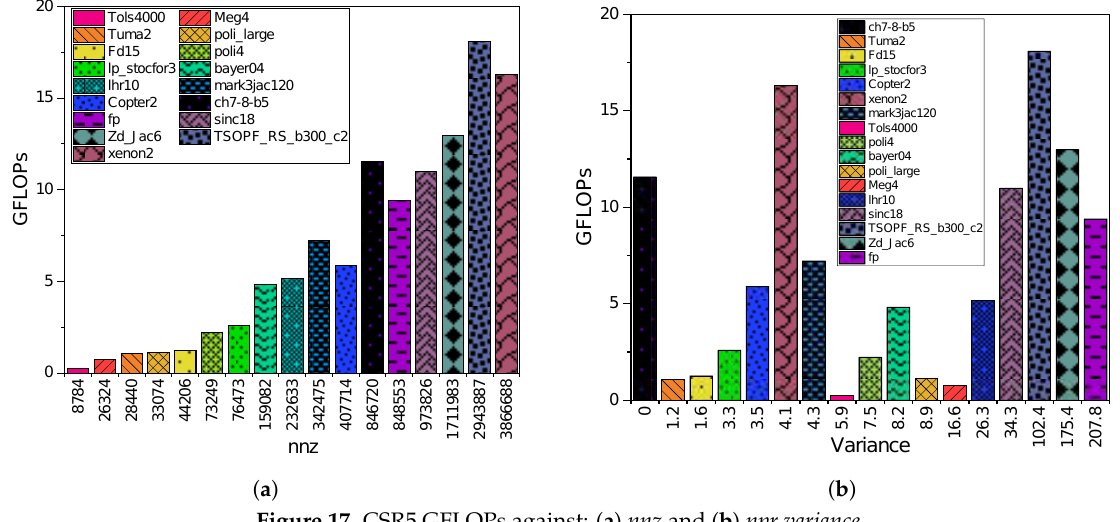
Figure 17. CSR5 GFLOPs against: ( a ) nnz and ( b ) npr variance